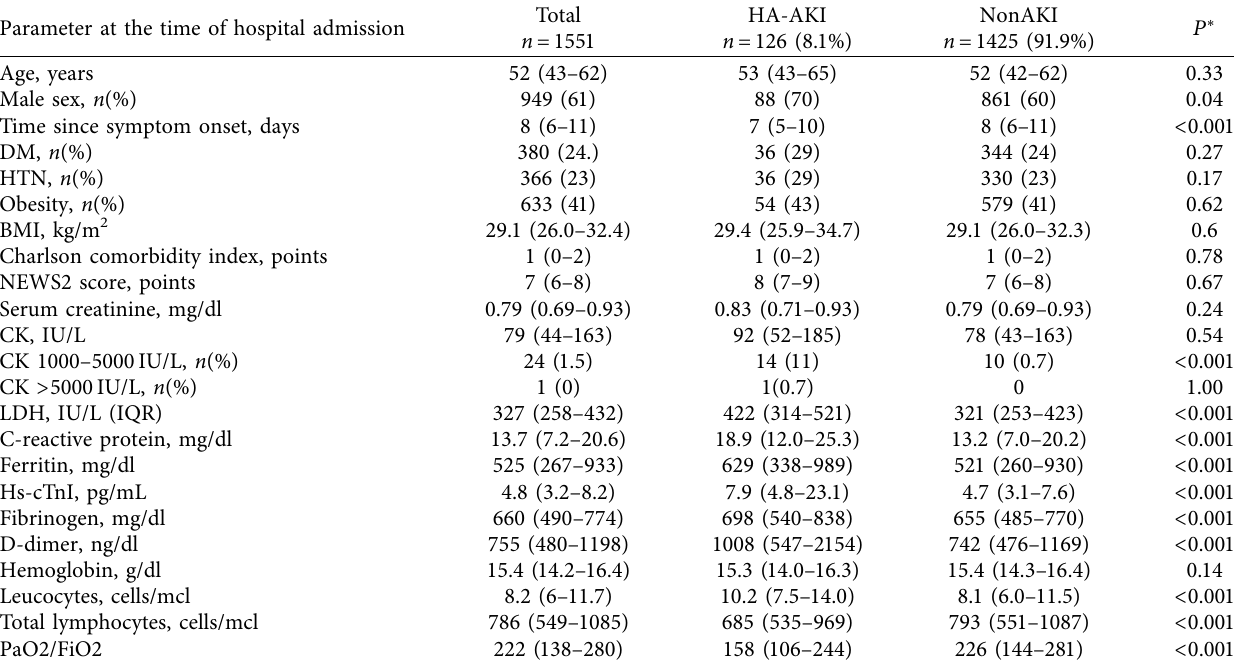
Table 1: Cohort characteristics at the time of hospital admission.